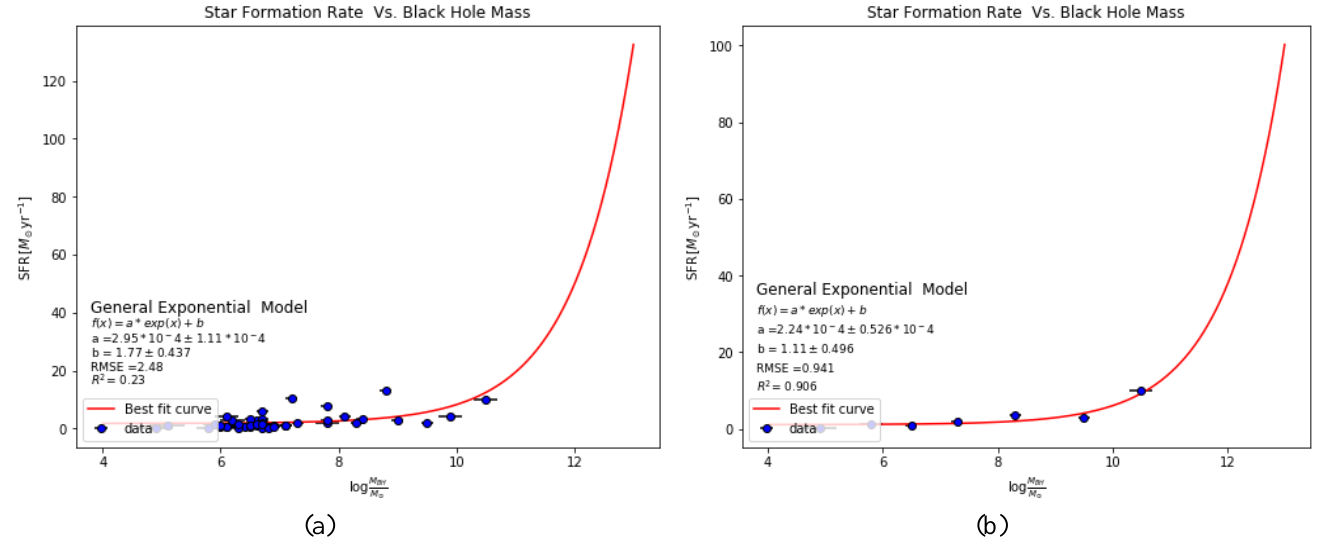
Fig.6: The correlation between the SMBH & SFR for seyfert2 galaxies using exponential regression, where (a) for all samples, (b) median